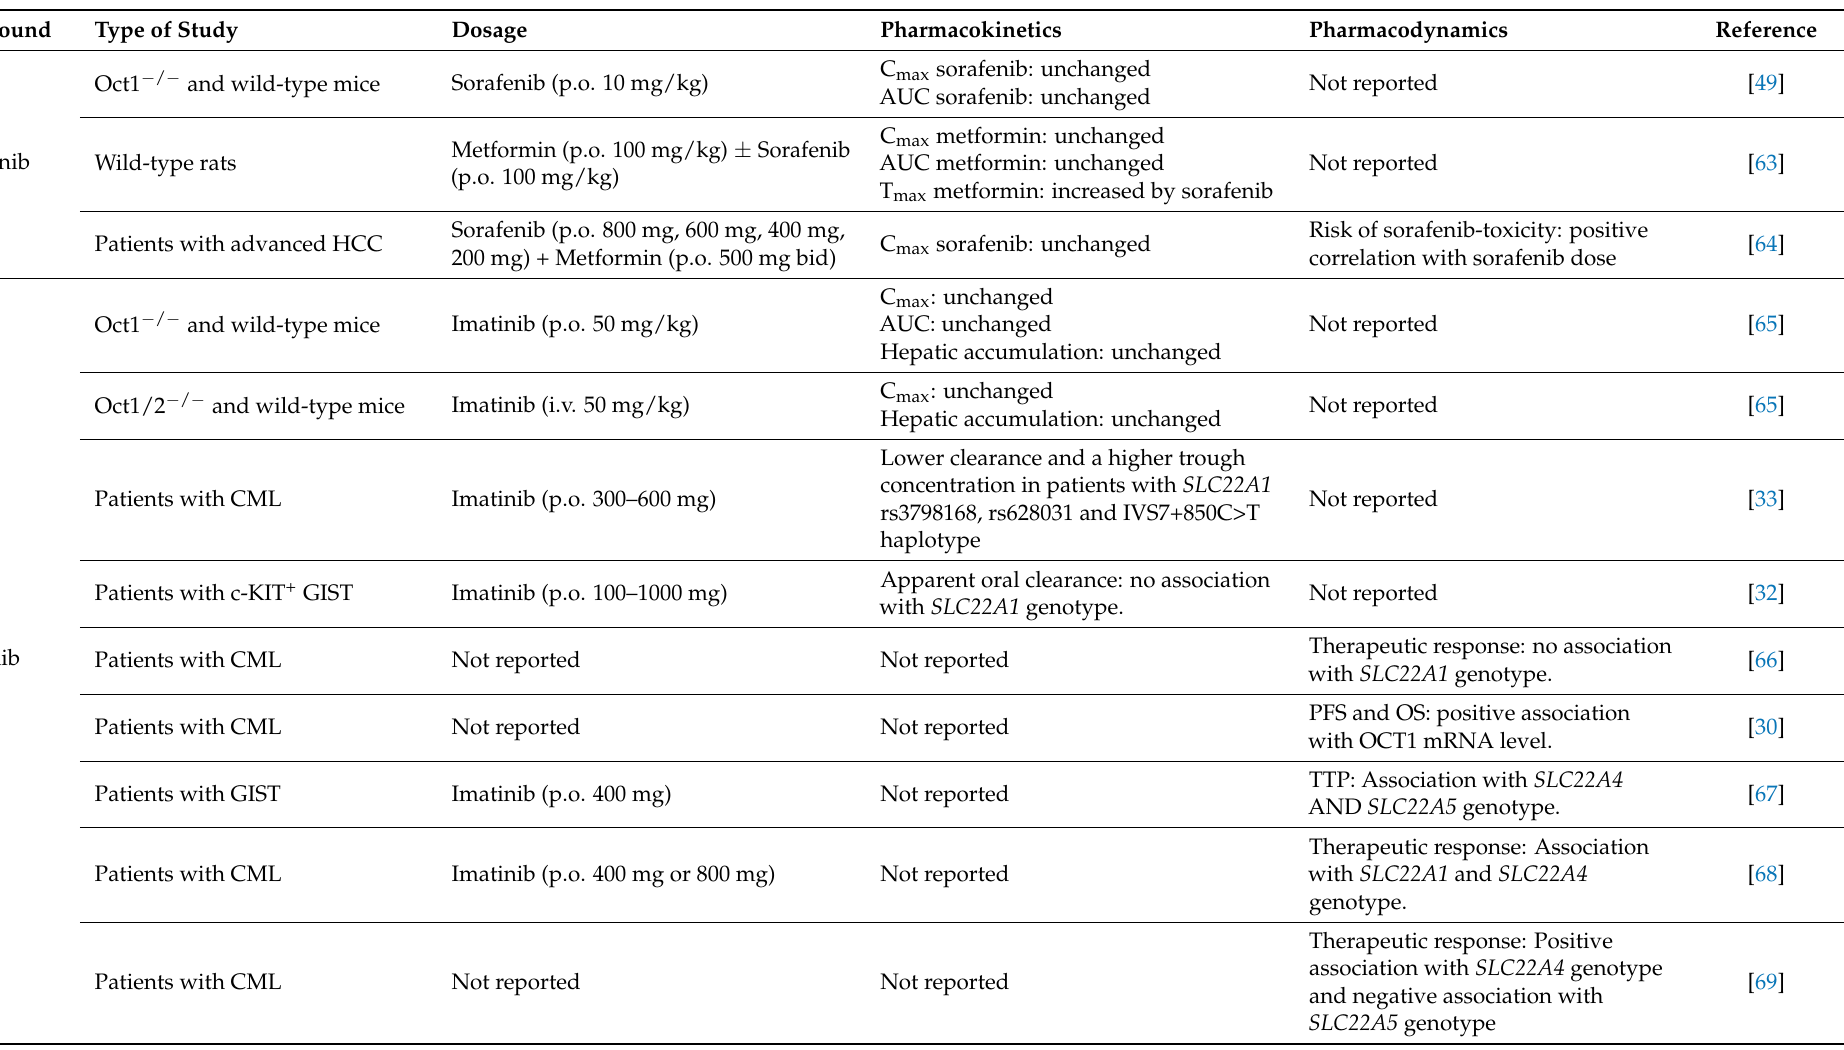
Table 2. OCT-TKI interaction in